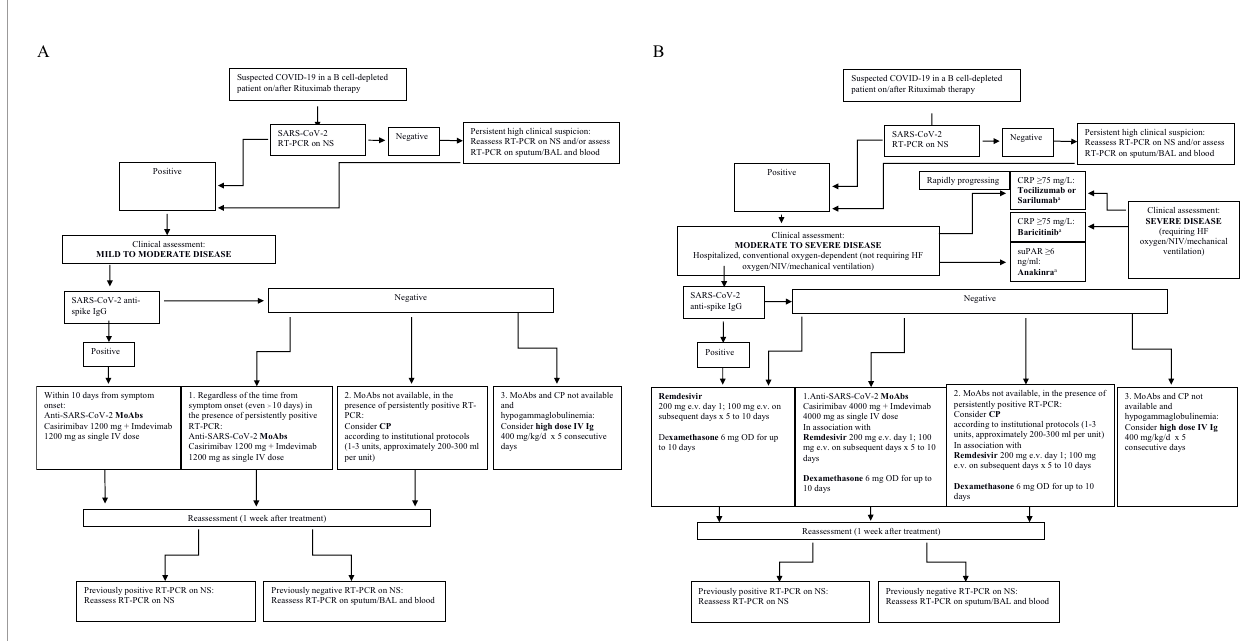
FIGURE 1 | (A) A potential therapeutic approach to immune compromised B cell-depleted patients with COVID-19 on/after Rituximab therapy. Mild to moderate disease. MoAbs, monoclonal antibodies; CP, convalescent plasma; Ig, Immunoglobulins. (B) A potential therapeutic approach to immunocompromised B cell- depleted patients with COVID-19 on/after Rituximab therapy. Moderate to severe disease. MoAbs, monoclonal antibodies CP, convalescent plasmas; Ig, Immunoglobulins; HF, high fl ow; suPAR, plasma Soluble Urokinase-Type Plasminogen Activator Receptor. a The role of anti-in fl ammatory drugs in B cell-depleted patients with COVID-19 on/after Rituximab may be questionable due to the lower levels of in fl ammatory biomarkers typically observed in non seroconverters and needs to be assessed in dedicated